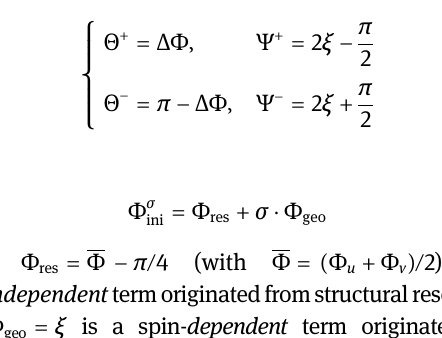
→ → → ( r ) , Θ σ ( r ) , Ψ σ ( r )} under LCP and RCP illuminations, generating two distinct ini